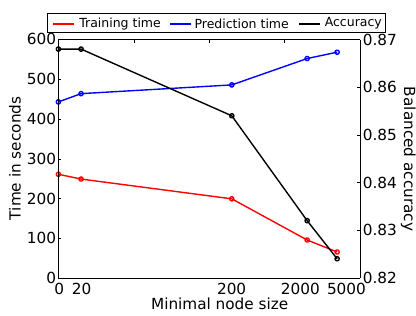
Figure 5. Influence on computation time and accuracy by constrained node optimization.